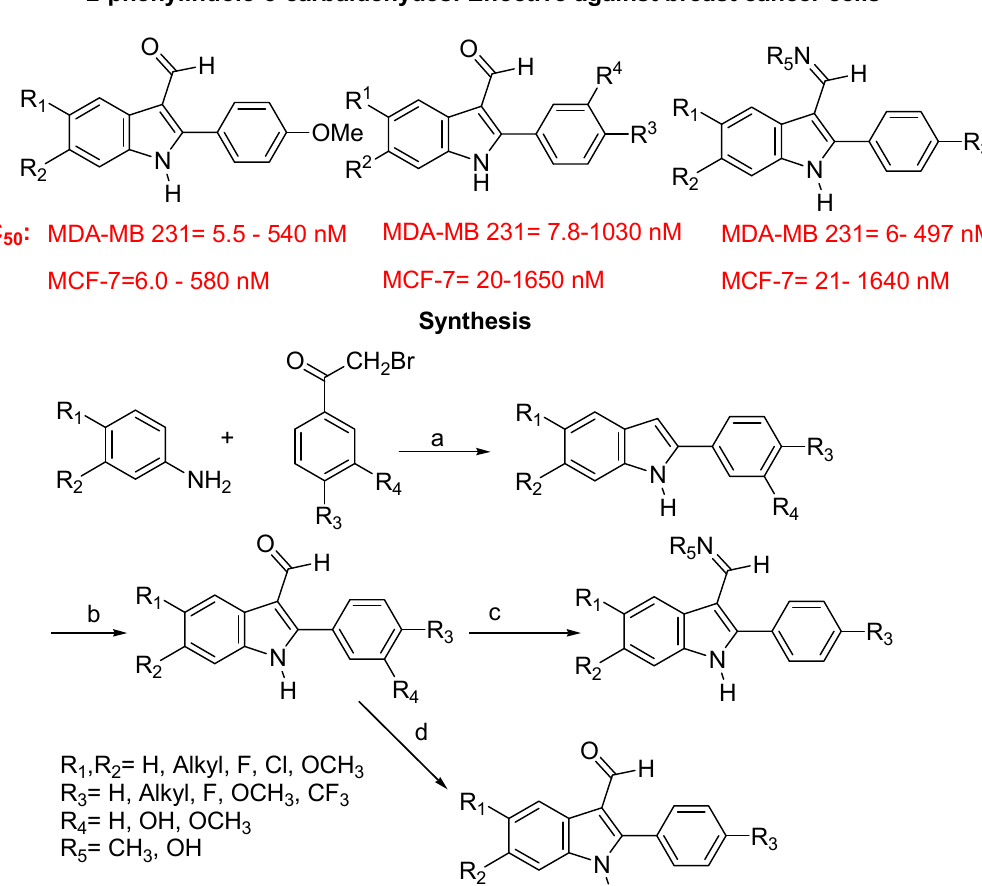
Figure 31. 2-Phenylindole-3-carbaldehydes derivatives as anticancer agents. 2-phenylindole-3-carbaldehydes: Effective against breast cancer cells